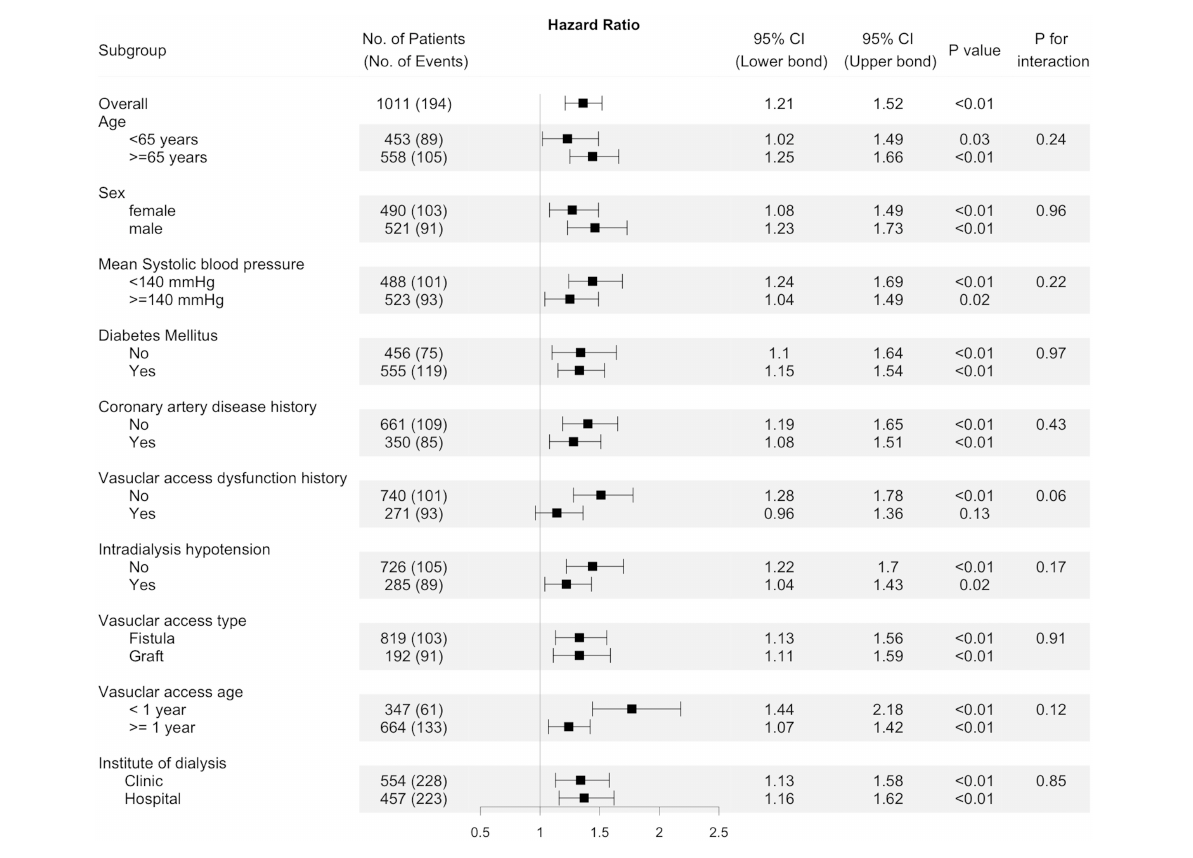
FIGURE4 Subgroup analyses. Unadjusted hazard ratio of thrombosis events per one standard deviation increase of predialysis systolic blood pressure variability (BPV) in different subgroups of patients. The interaction of factors in each subgroup on the association of BPV with thrombosis were presented by the “ p for